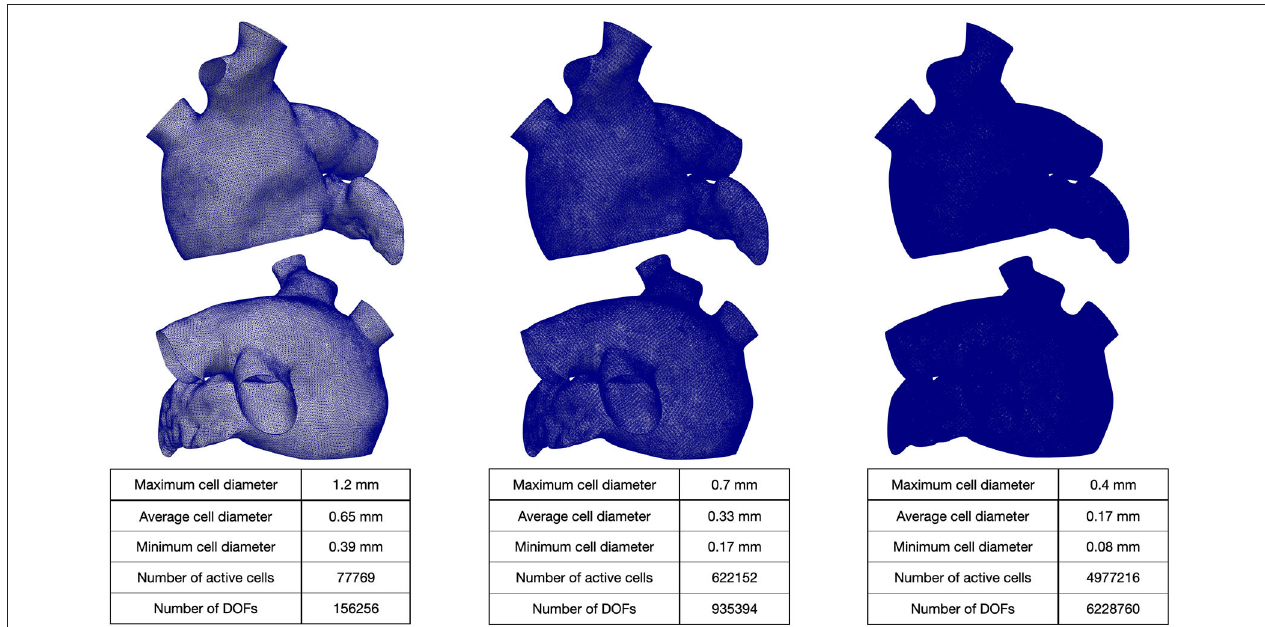
FIGURE 3 | Hexahedral meshes with different levels of refinement. The geometry was obtained from Zygote solid 3D heart model (Zygote Media Group Inc., 2014).